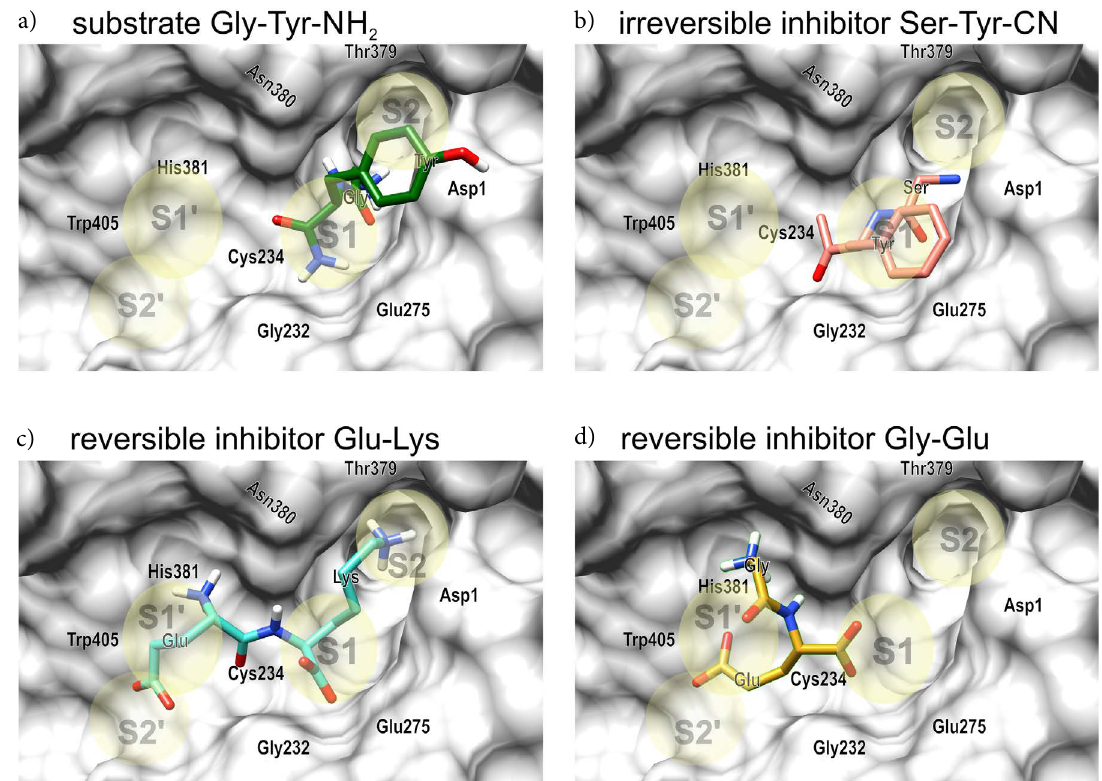
Figure 5. The active site of cathepsin C with selected predicted positions of dipeptides using docking predictions in comparison to the experimen- tally determined position of the inhibitor Ser-Tyr-CN in the crystal structure of cathepsin C. 22 Docking simulations of ligands were performed using the Autodock Vina Plugin 31 and the results were visualized with UCSF Chimera 1.13rc. 30 (a) The predicted accommodation of dipeptide-amide